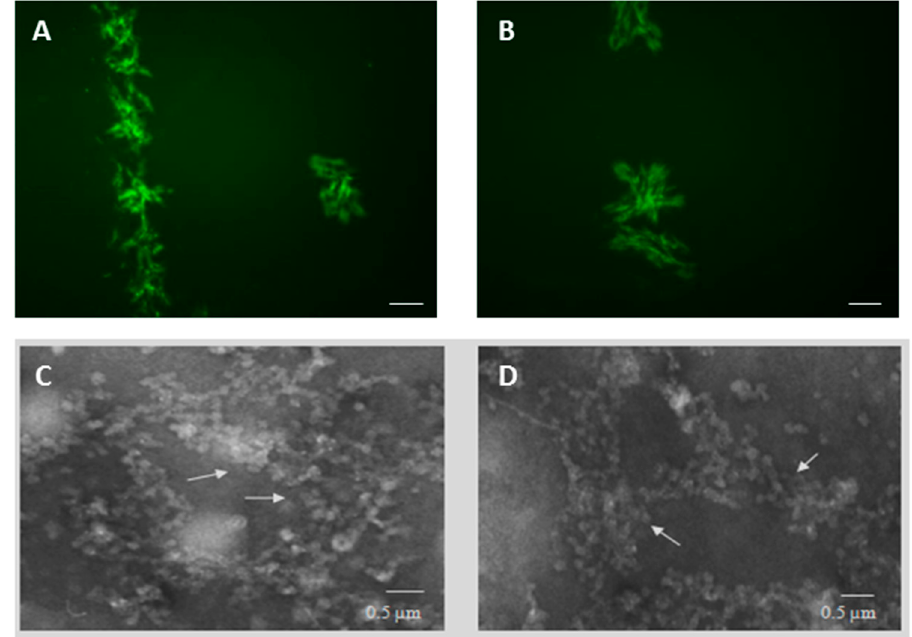
Figure 2. PT-gliadin fluorescent and ultrastructural visualization. ( A , B ) Labelled PT-gliadin (GLIA-488, 10 µg) was added in 1 mL DMEM medium and visualized by fluorescent inverted microscope Eclipse Nikon TS100 (scale bars = 10 µm). ( C , D ) TEM evaluation of PT-gliadin aggregates, indicated by arrows.